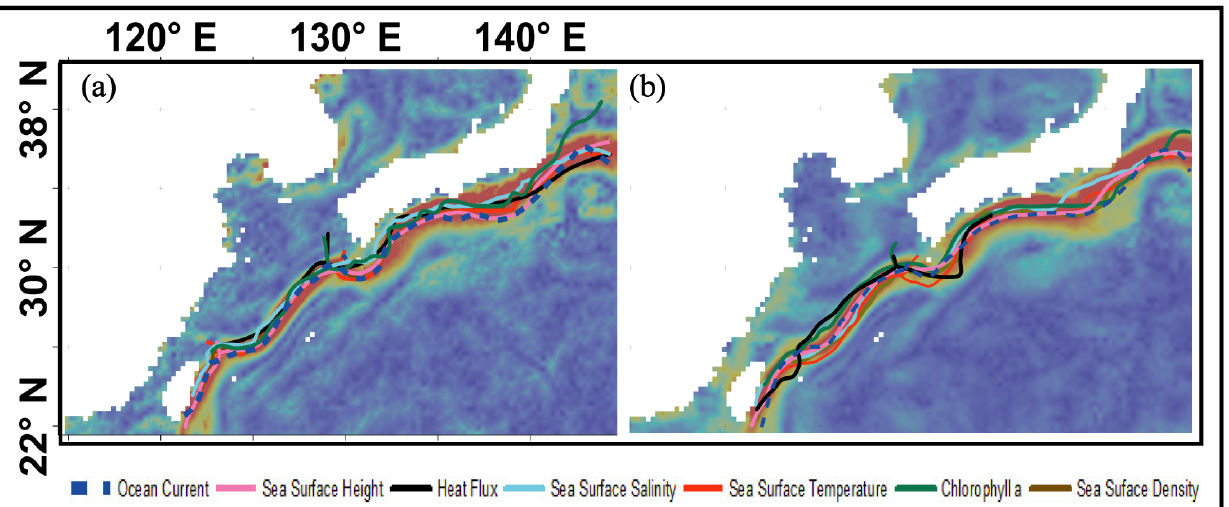
Figure 16. Kuroshio centerline from seven parameters overlay on Kuroshio from drifter data ( a ) January; ( b )